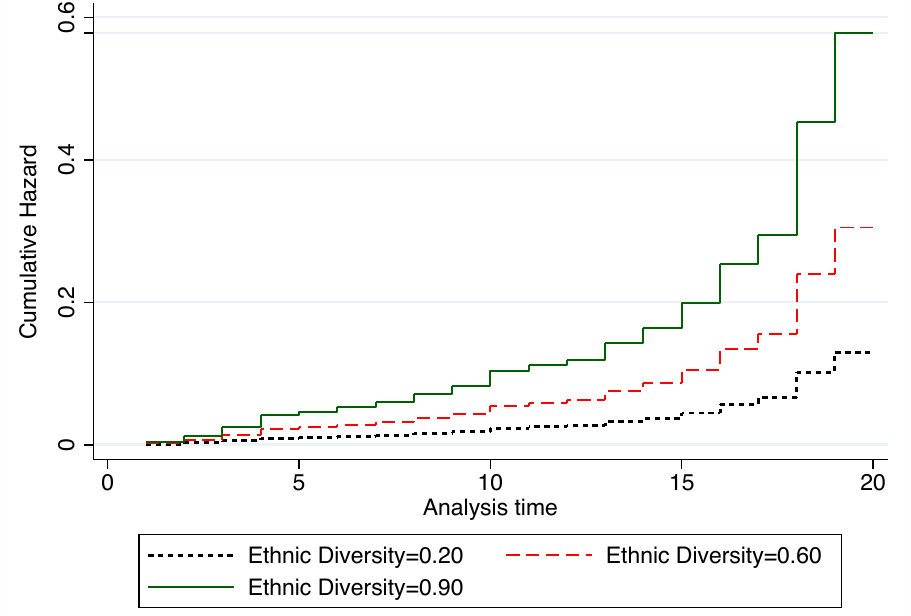
Figure 2: Cox proportional hazard regression: effect of ethnic diversity on the hazard of right-wing